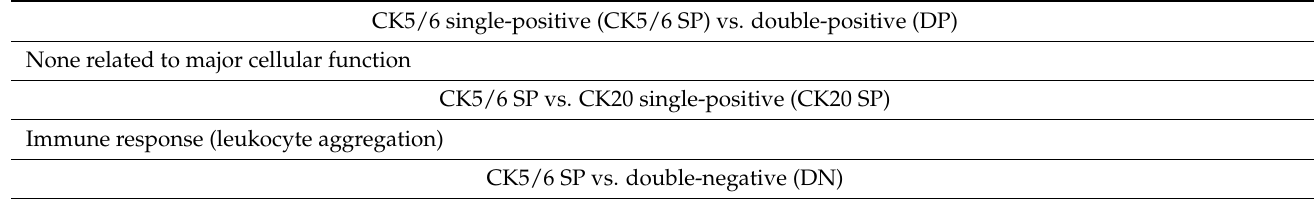
Table 1. The Gene Ontology (GO) analysis results between each